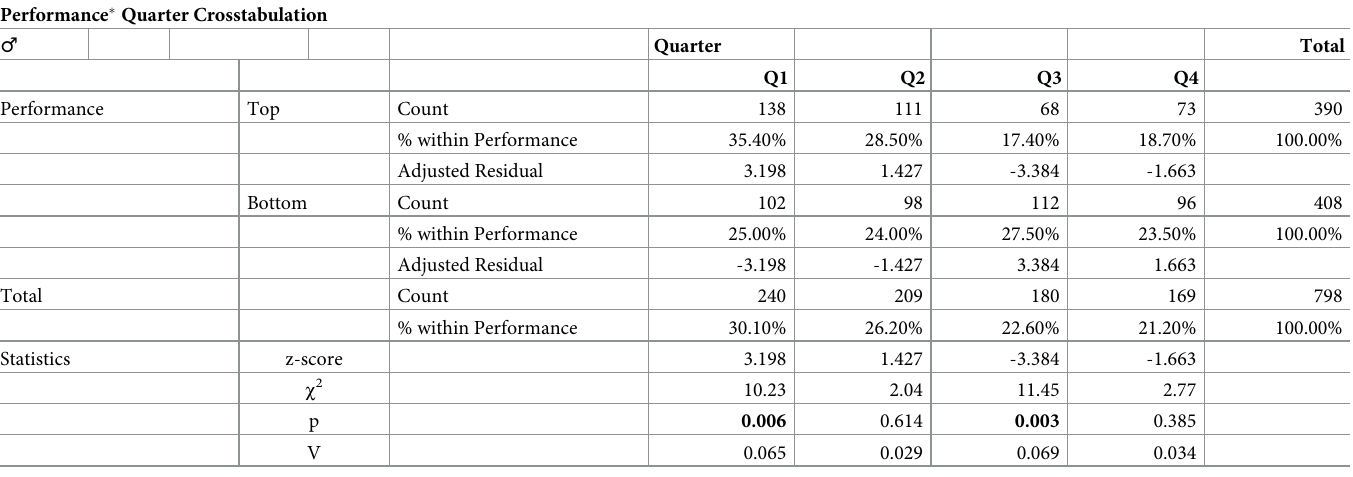
Table 5. Comparison of birthdate distribution between top-6 and bottom-6 teams. Performance � Quarter